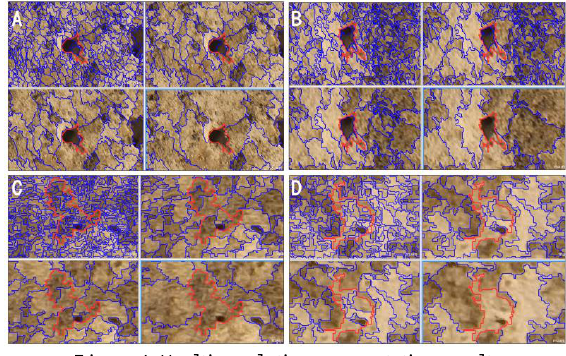
Figure 4. Multi-resolution segmentation